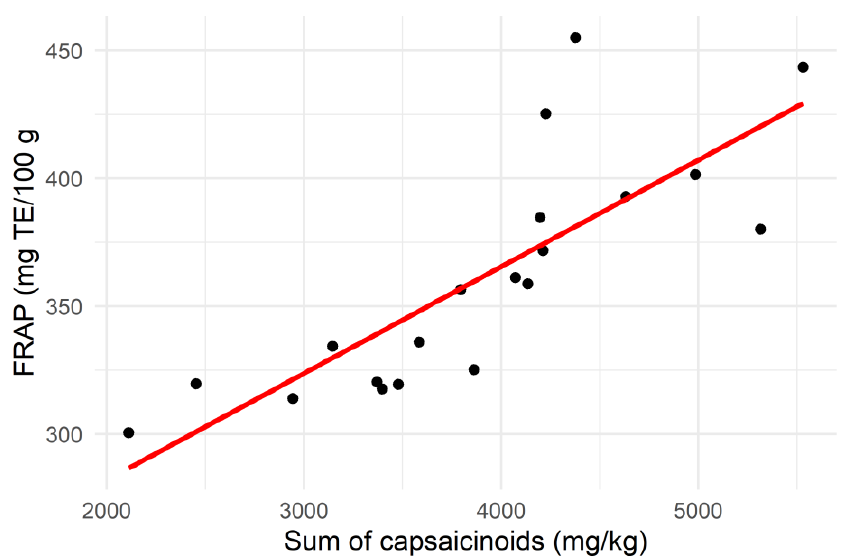
Figure 3. Scatter plot showing the relationship between the sum of capsaicinoid contents and the Ferric Reducing Antioxidant Power (FRAP) of the chilli samples ( n = Ferric Reducing Antioxidant Power (FRAP) of the chilli samples ( n = 20). The FRAP and TP content were only moderately correlated (R 2 = 0.58; p < 0.01), in